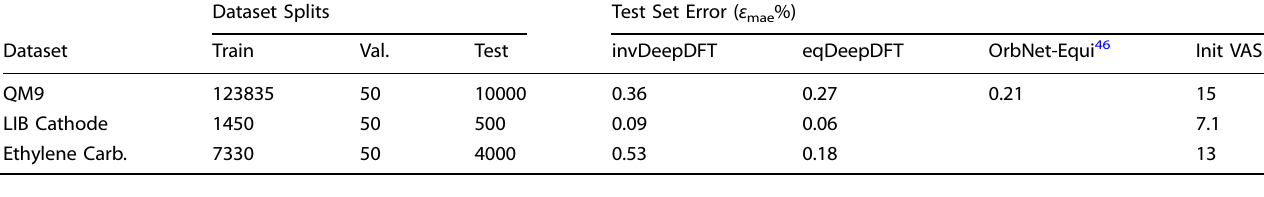
Table 1. Datasets and prediction errors for invariant and equivariant DeepDFT model. We also compare with OrbNet-Equi and the superposition of atomic densities as implemented in VASP. Dataset Splits